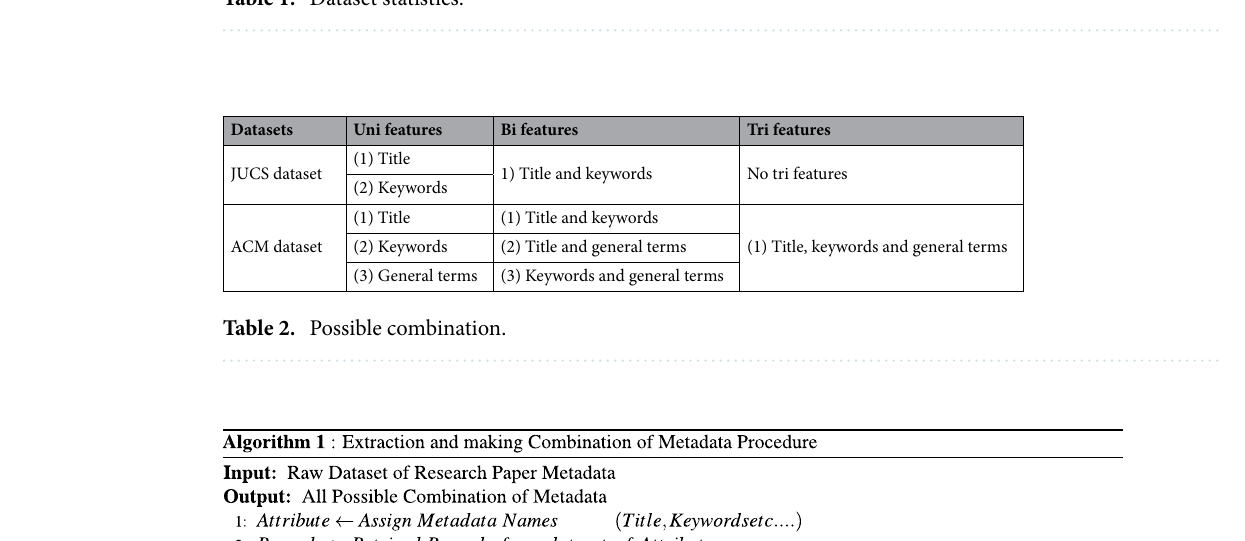
Table 1. Dataset statistics.